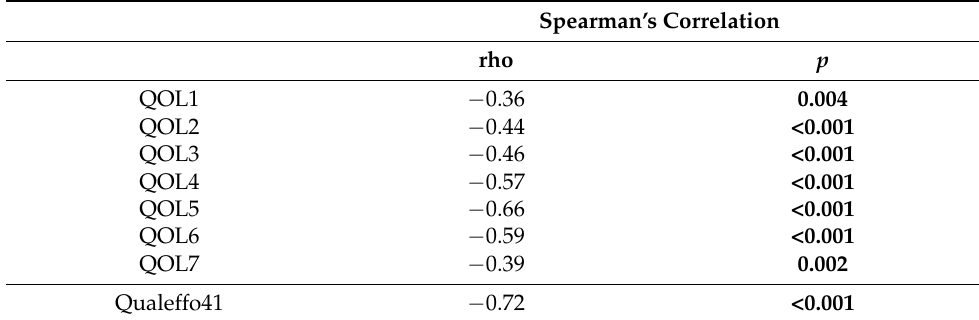
Table 3. Correlations between participants’ bone density and quality of life.